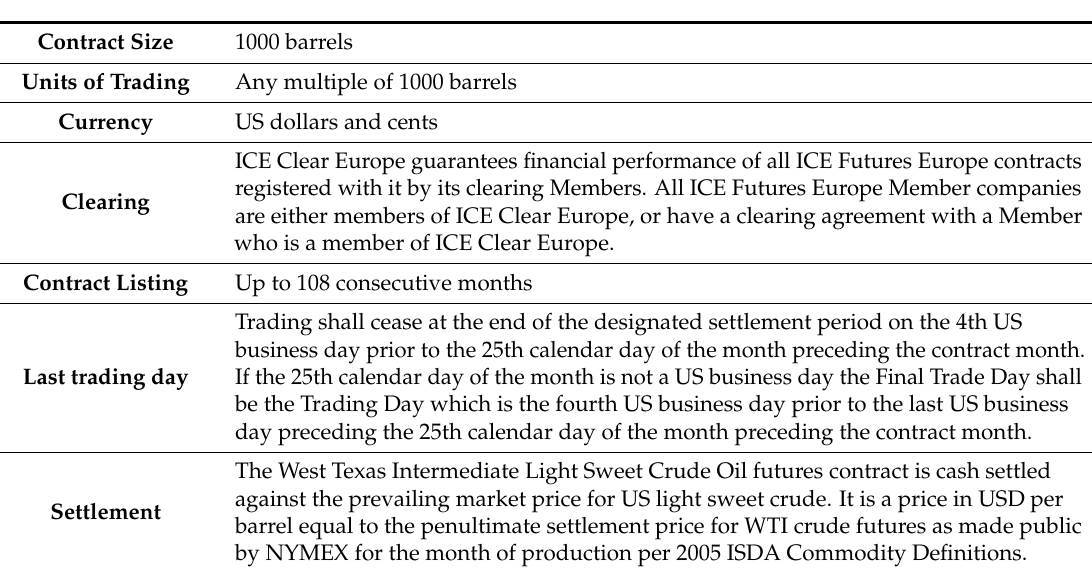
Table 1. WTI Crude Futures Market Specifications. Source: Intercontinental Exchange